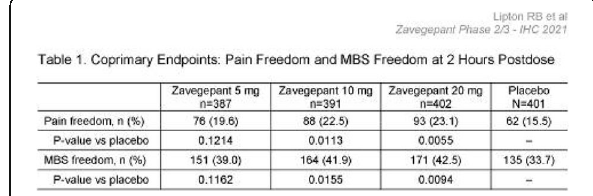
Table 1 (abstract P0267). See text for description